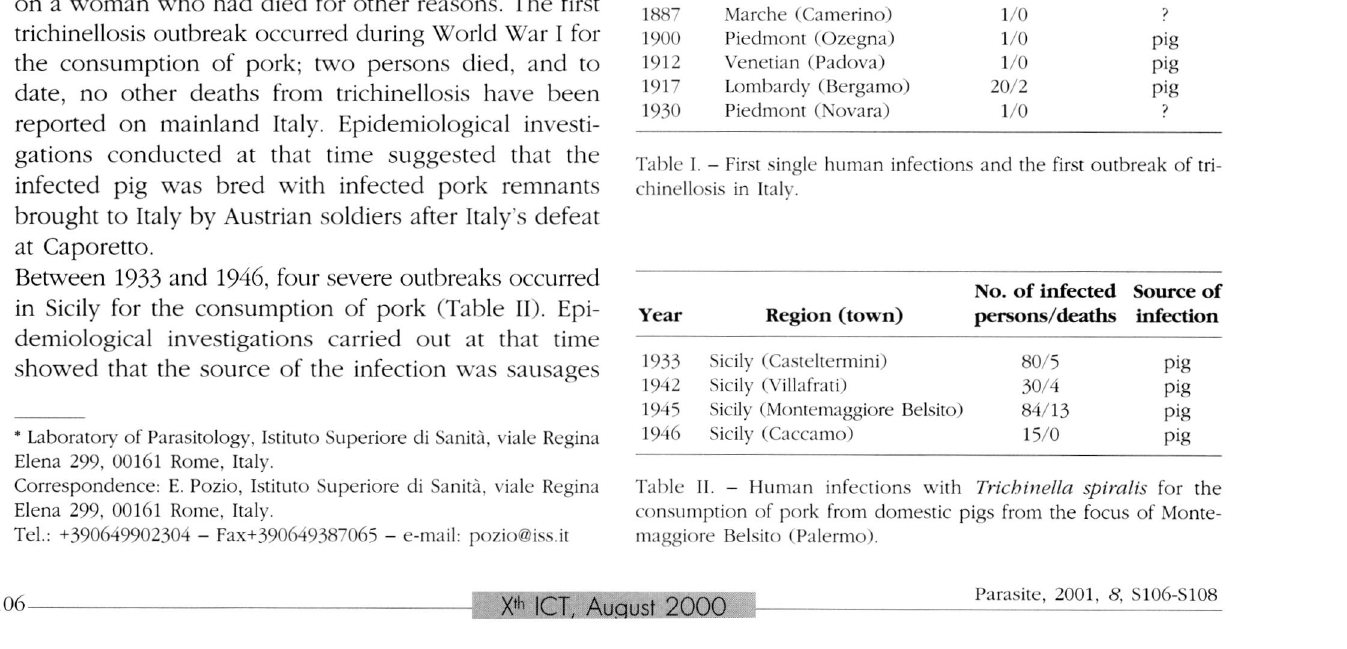
Table II. - Human infections with Trichinella spiralis for the consumption of pork from domestic pigs from the focus of Monte maggiore Belsito